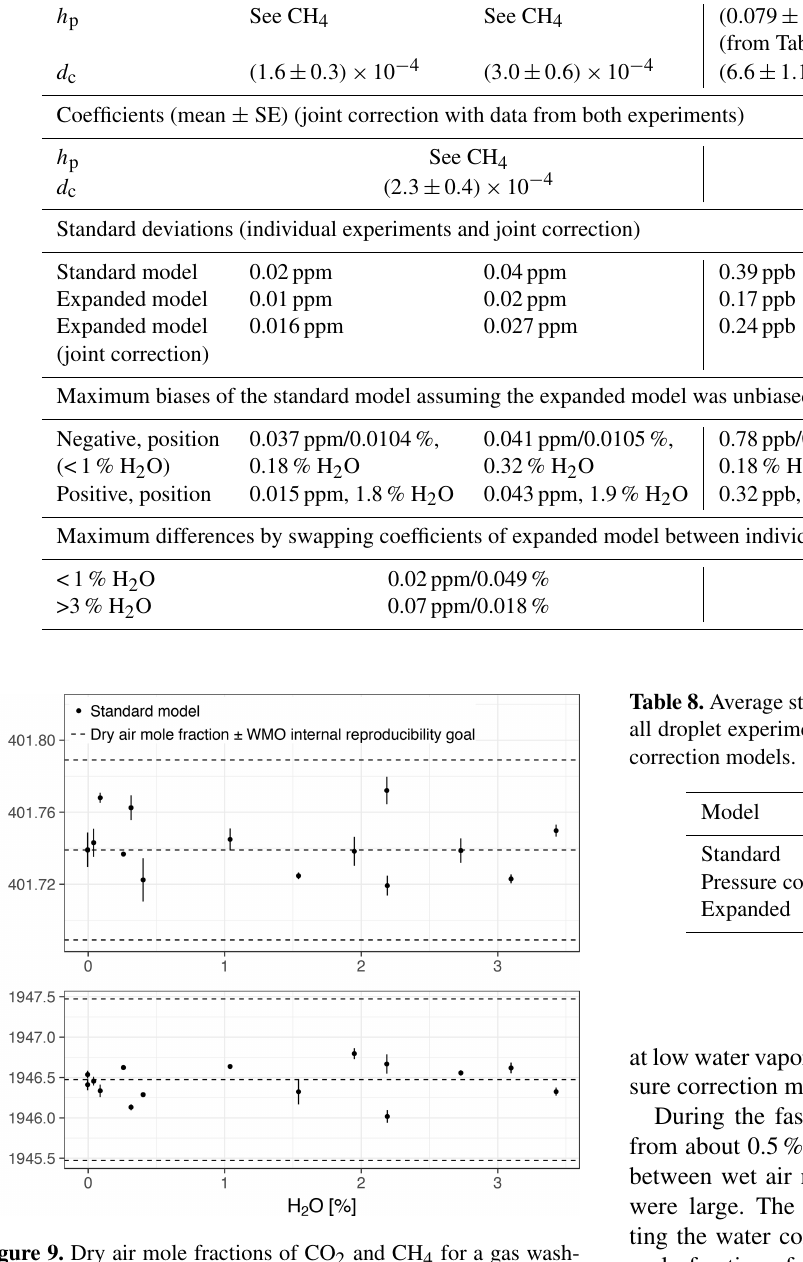
Figure 9. Dry air mole fractions of CO 2 and CH 4 for a gas wash- ing bottle experiment with Picarro no. 4 based on the standard wa- ter correction model. Error bars: lower bound of uncertainty; see Sect. S3. The dashed lines are the same as in Fig. 7.